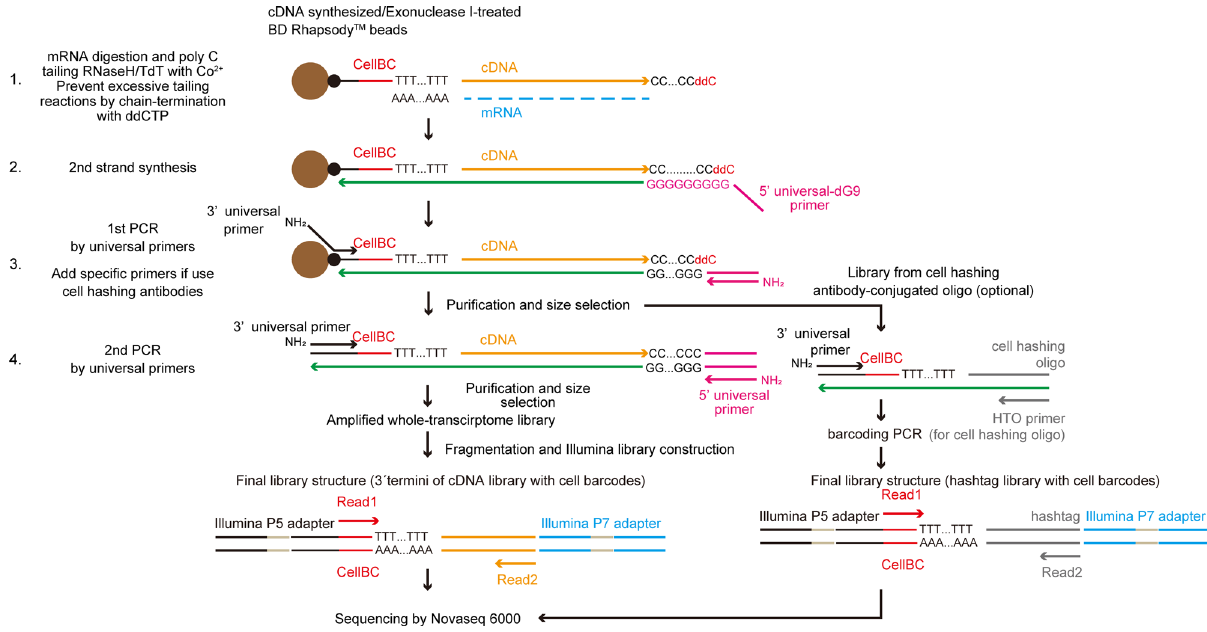
Fig. 1 Principles of TAS-Seq. Diagram of the TAS-Seq library preparation work fl ow. First, cDNA synthesis on BD Rhapsody magenic beads were performed. After Exonuclease I treatment, dC-tailing reaction was performed by TdT/RNase H. Tailing reaction was stochastically stopped by ddCTP incorporation into 3' termini (1). Next, second-strand synthesis was performed using 5'universal-dG9 primer and PCR master mix (2). Then, 1st PCR was performed by appropriate primers (3 ′ and 5' universal primer (if only amplify cDNA) or 3 ′ , 5' universal primer and HTO primer (if use cell hashing antibodies)) (3). Resultant libraries were size-selected and ampli fi ed by 2nd PCR (4). cDNA libraries were fragmented, ligated, and truncated with Illumina P7 adapters, and 3 ′ termini of cDNA molecules with cell barcodes were enriched by PCR ampli fi cation. During the PCR step, we introduced unique-dual barcodes to the Illumina adapters to minimize index hopping. Finally, libraries were sequenced by Illumina Novaseq